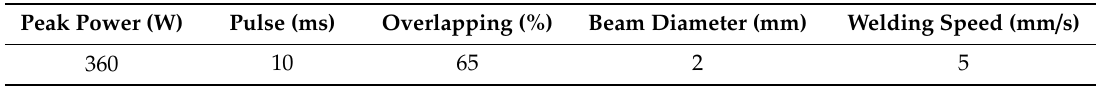
Table 2. Welding parameters used.